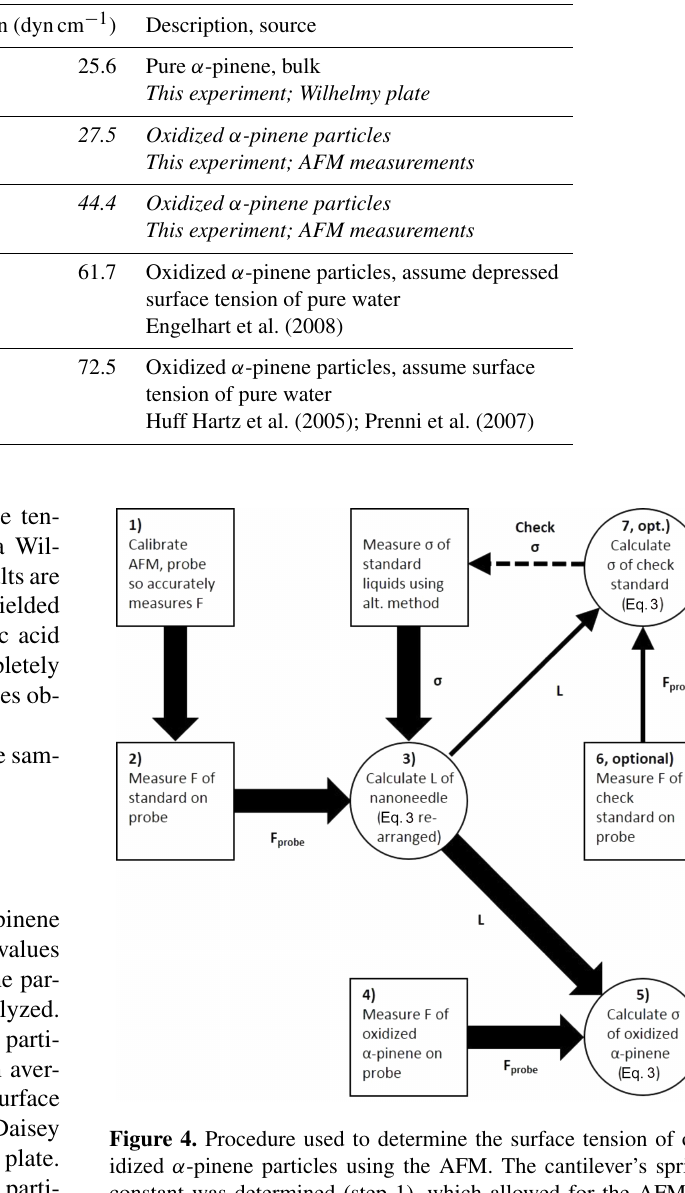
Table 3. Measured and approximated surface tensions of α -pinene particles. Bulk α -pinene and dry, oxidized α -pinene particles have a similar surface tension. Wet α -pinene particles have a higher surface tension. Measurements from this study are shown in italicized font, other values are given for context.